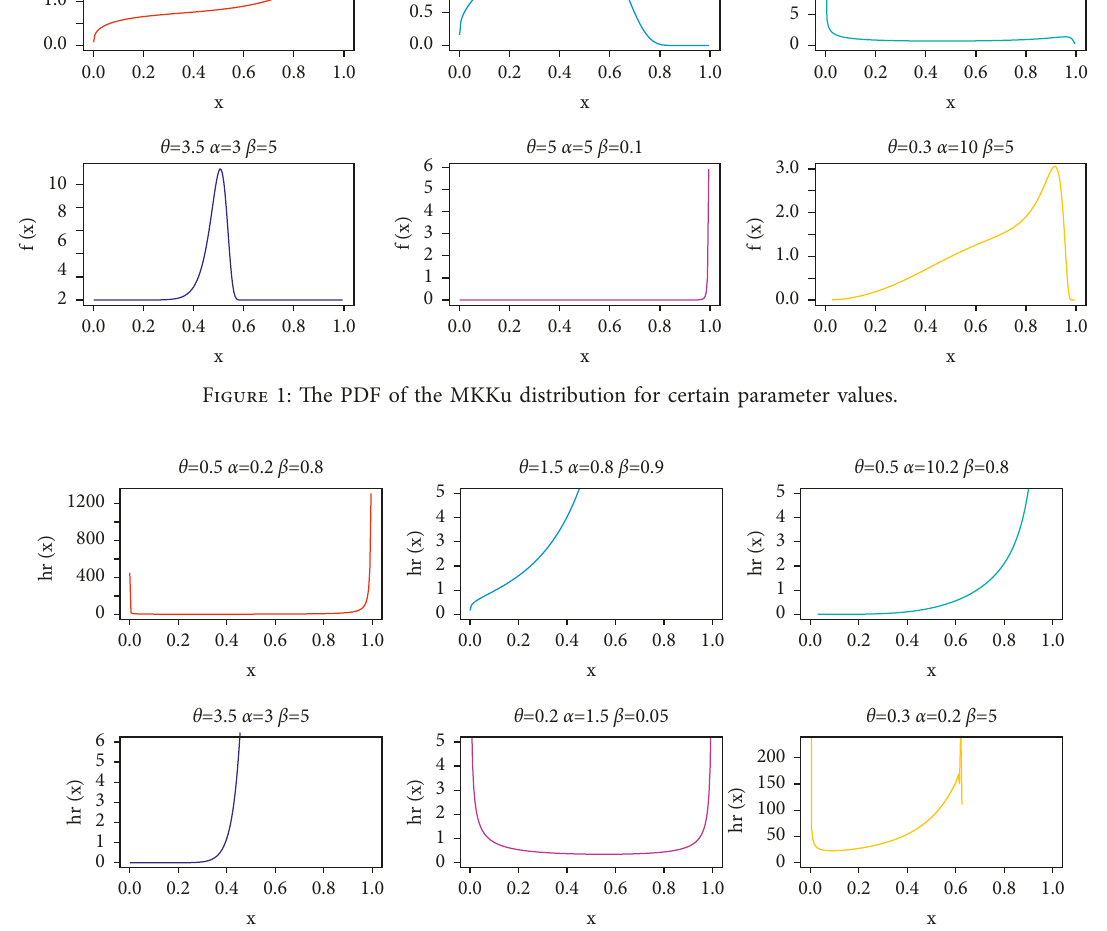
Figure 2: HR of the MKKu distribution for different parameter